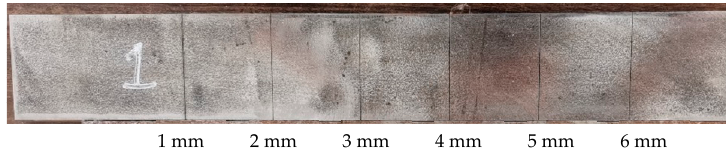
Figure 14. Metal plates with different depths of crack defects.